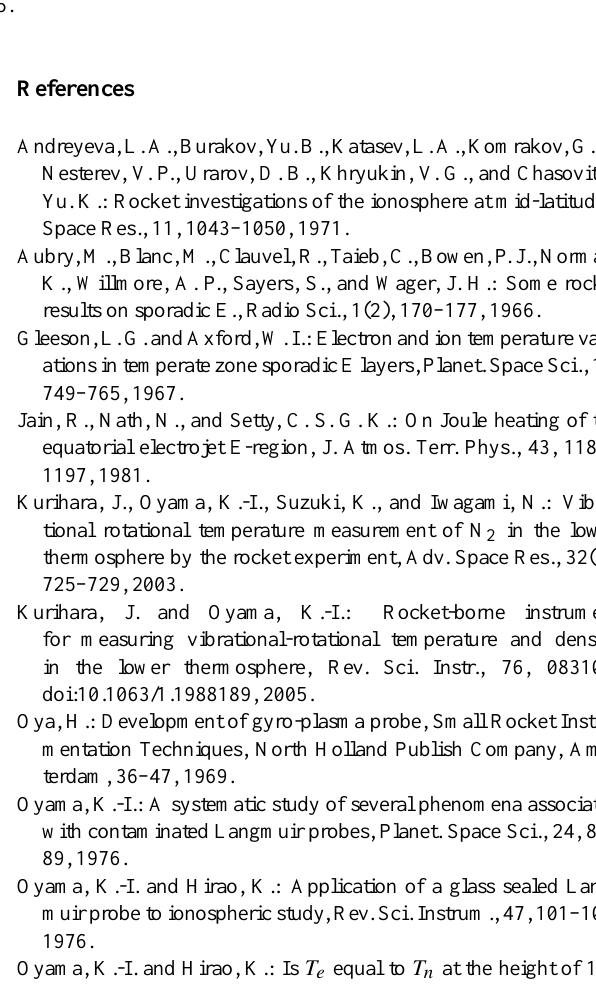
Fig. 6c. Same as Fig. 6a but for H, G, and I, which are marked in Fig.